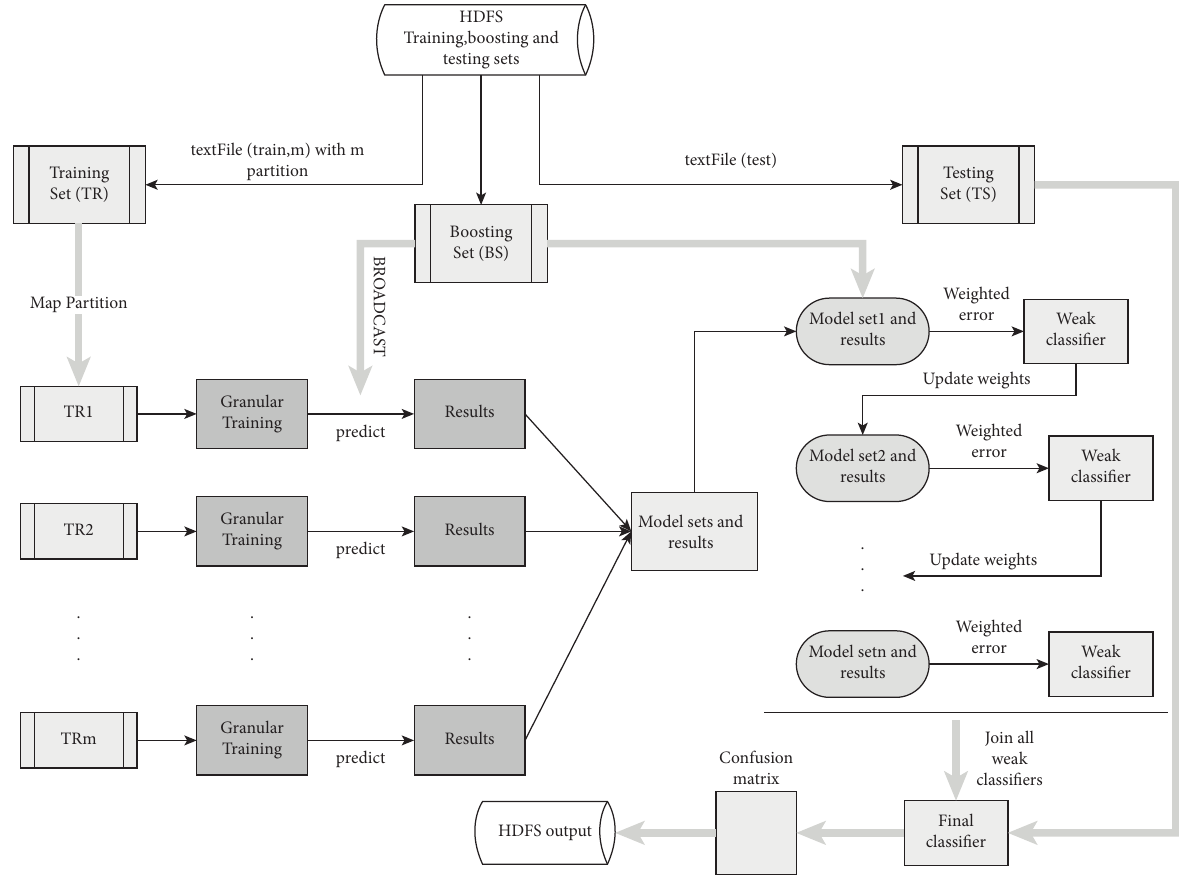
Figure 1: Algorithm framework